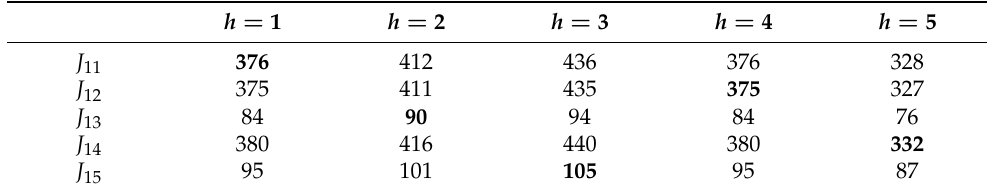
[ 1 ] for (cid:102) G 1 (bold numbers are the optimal solution). jh